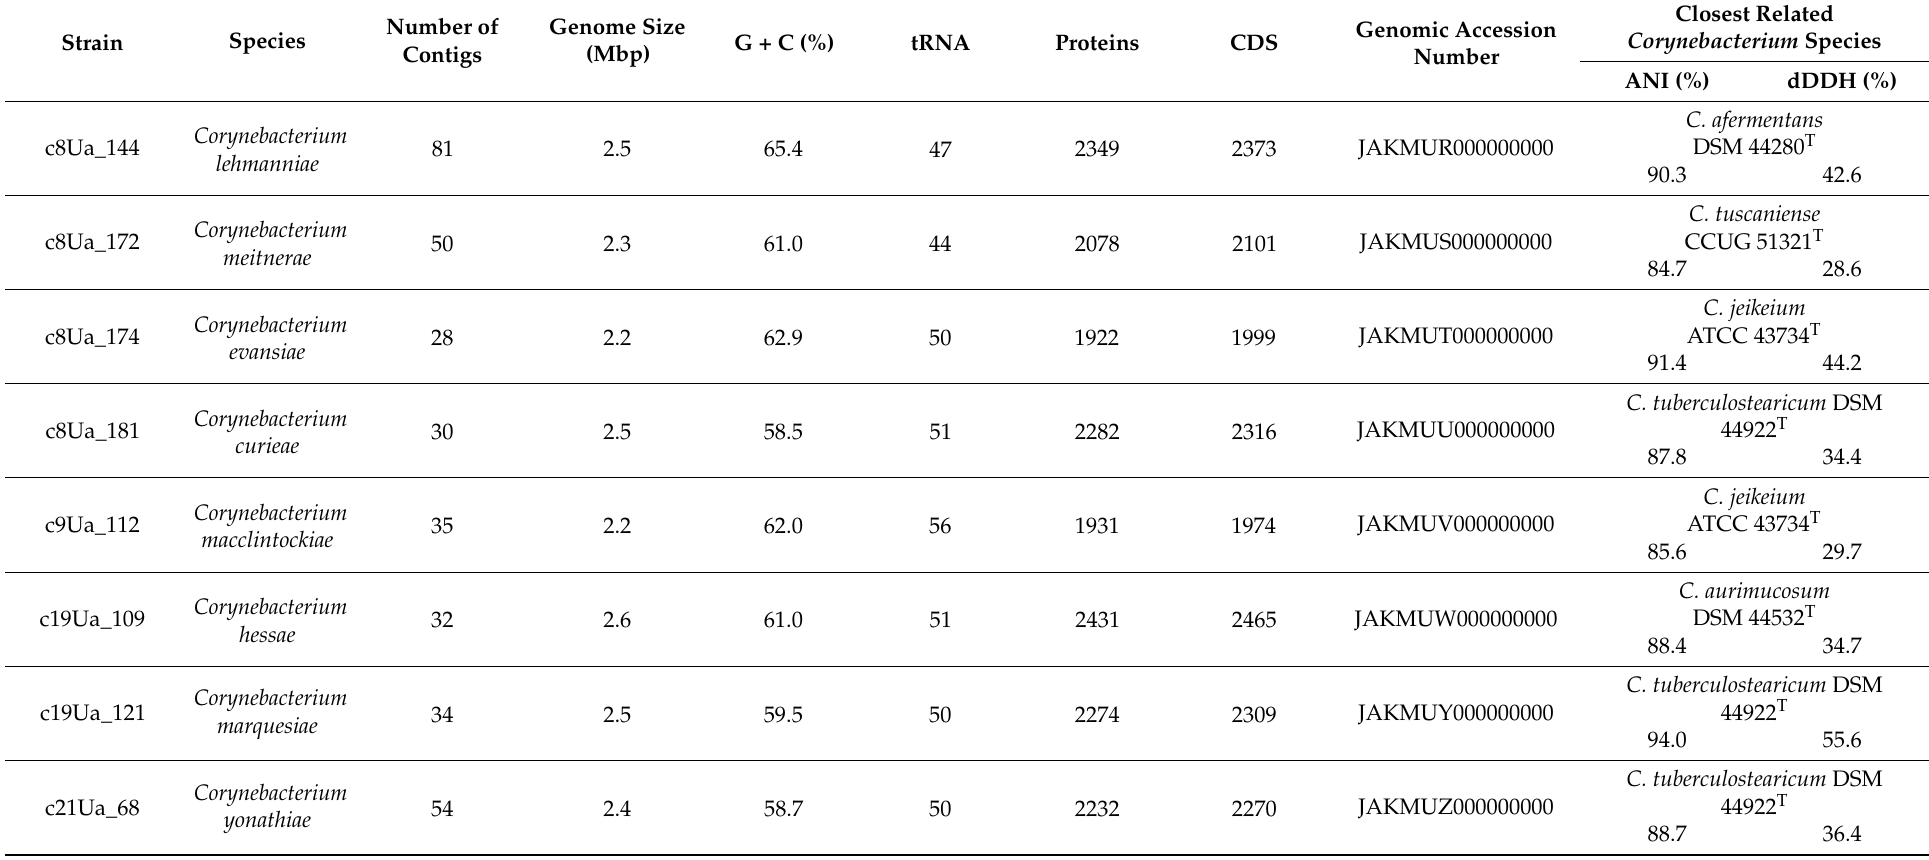
Table 1. Genomic features of the Corynebacterium strains analyzed in this